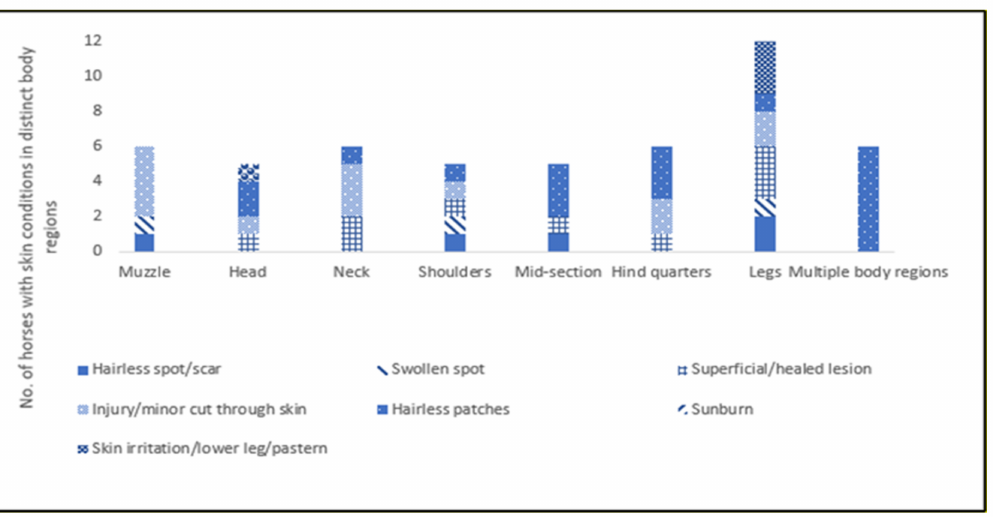
Figure 2. Number of horses with different types of skin conditions (body lesions, hairless patches, sunburn and skin Irritation 0n lower legs/pastern) recorded in distinct body regions.